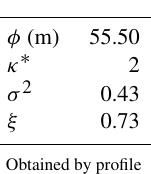
Table 2. Maximum likelihood estimate of spatial covariance param- eters for soil uranium.